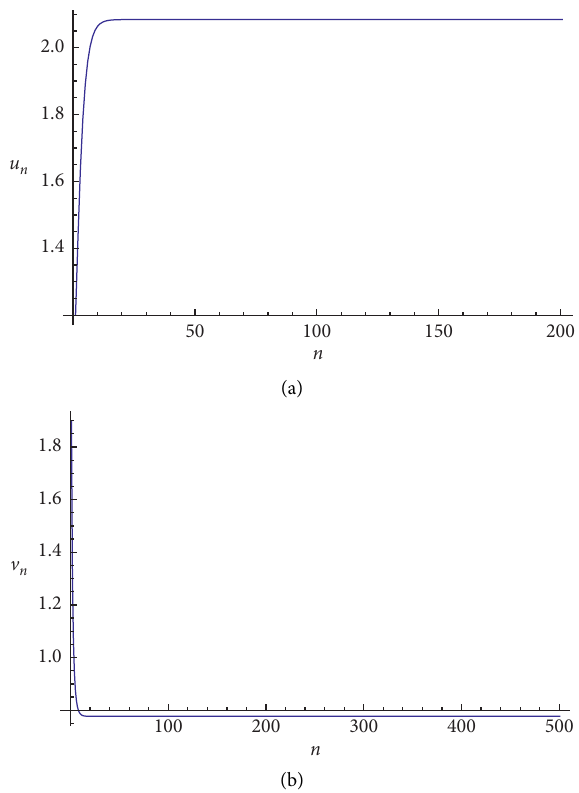
Figure 3: Phase portrait of system (54) with ( u